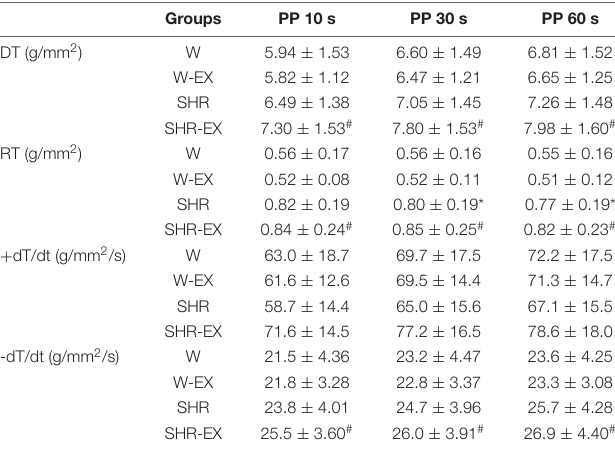
TABLE 4 | Papillary muscle function after post-resting contraction.